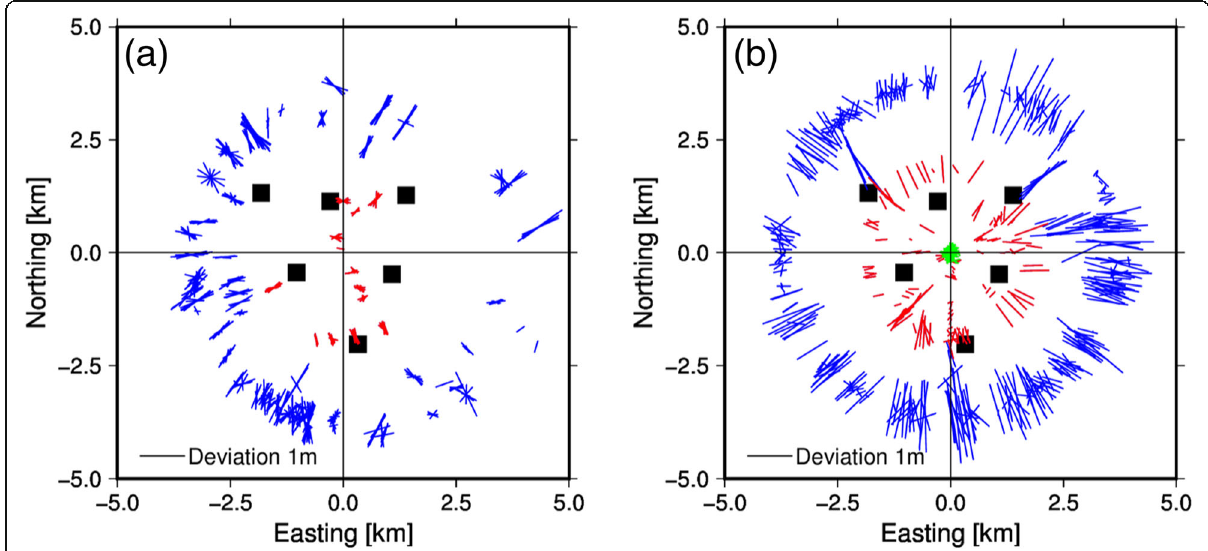
Fig. 6 Array positions projected as bars as a function of observation position.A bar represents the horizontal deviation of array positions ( ffiffiffiffiffiffiffiffiffiffiffiffiffiffiffiffiffiffiffi q δ x 2 þ δ y 2 ) based on ( a ) buoy-based observation and ( b ) ship-based observation. The black bar located at the bottom left in each panel indicates a deviation scale of 1 m deviation. The blue bars correspond to observation positions outside the array, and the red bars correspond to observation positions inside the array. The orientations of the bars indicate the orientations of array positions relative to the initial